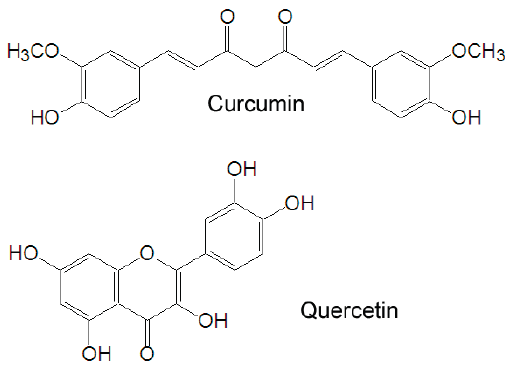
Figure 1. Chemical structures of quercetin and